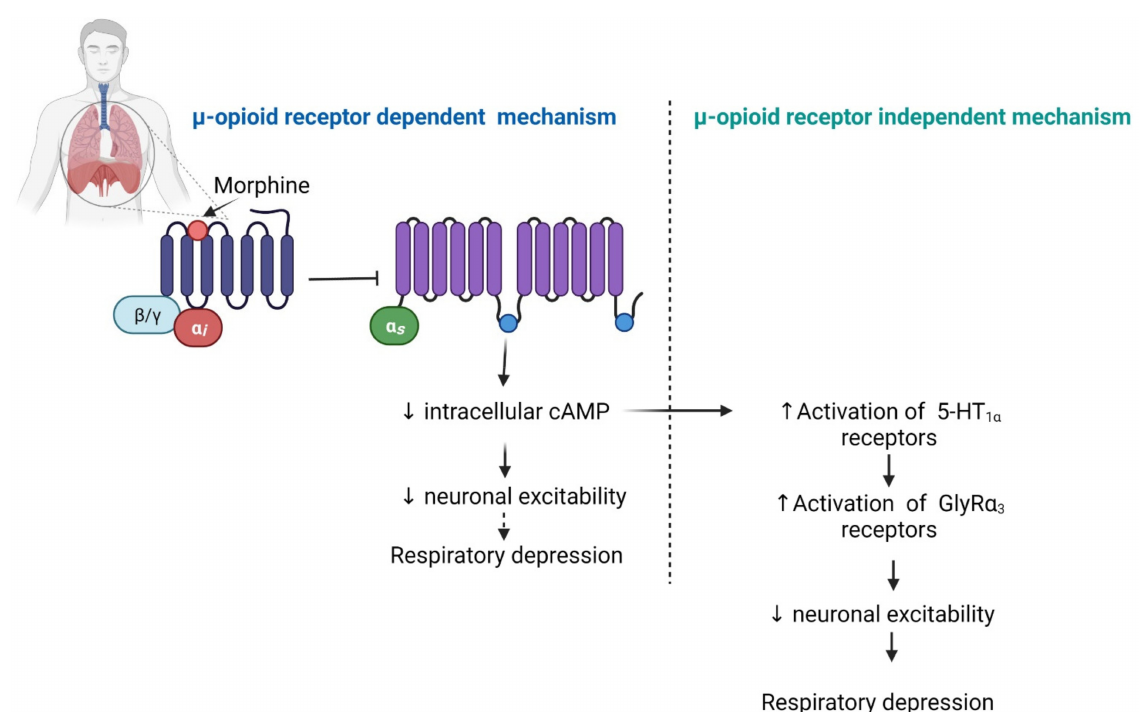
Figure 4. Effects of opioids on the respiratory function. Abbreviations: 5-HT, serotonin; GlyR α 3, glycine receptor type- α 3. Symbols: solid arrow, strongly connected; dashed arrow, moderately connected; upward arrow (symbol), increased effect; downward arrow (symbol), decreased effect. The figure was made with www.biorender.com (accessed on 19 October